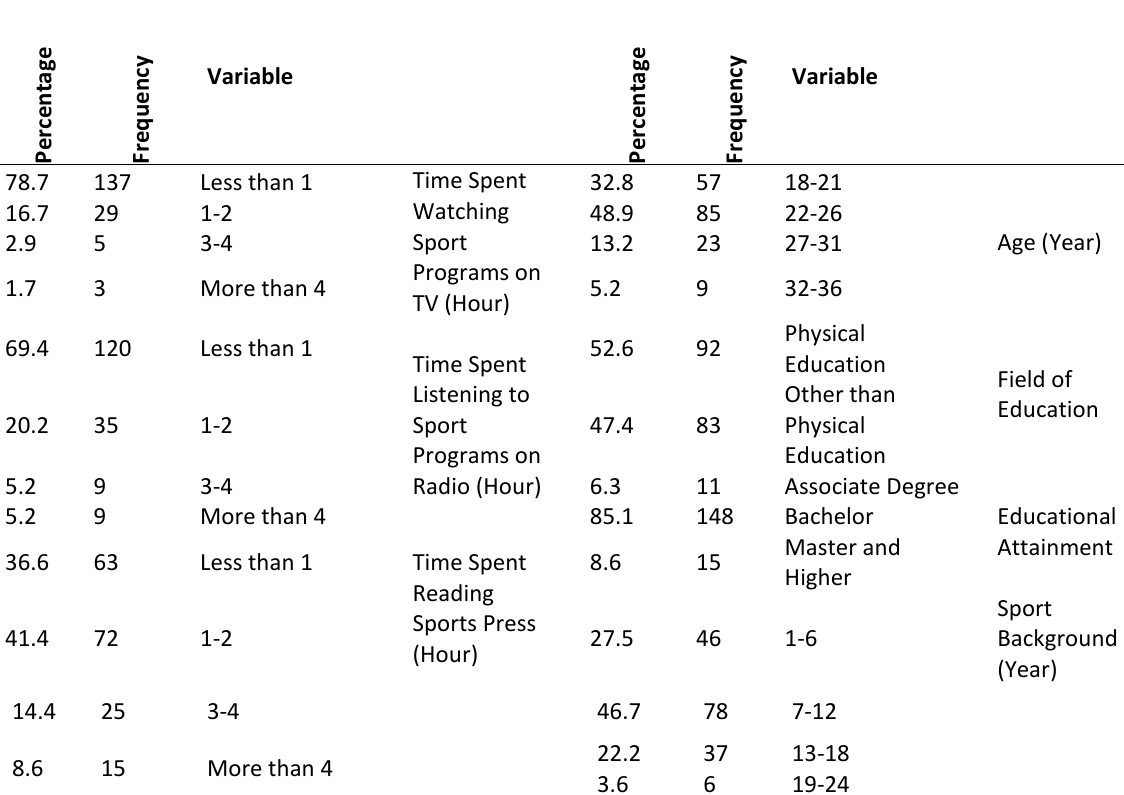
Table 1. Description of Personal Characteristics of